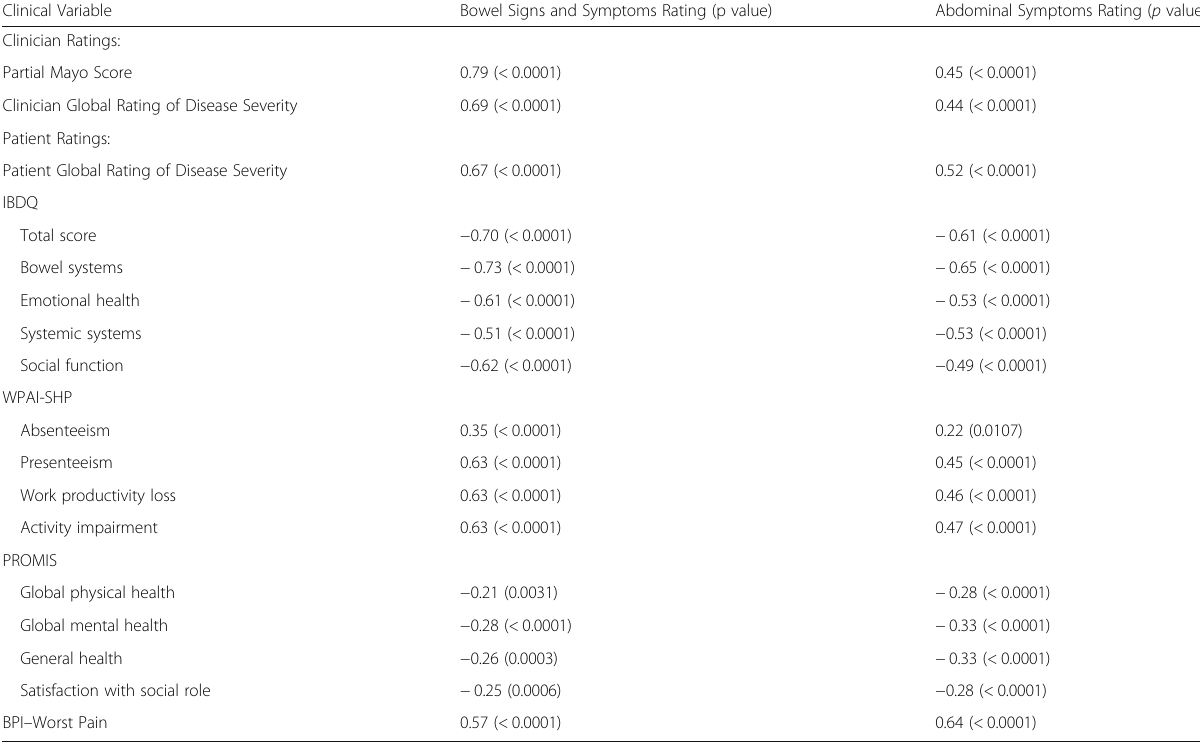
Table 3 Correlations between UC-PRO/SS Scores and Other Clinical Variables